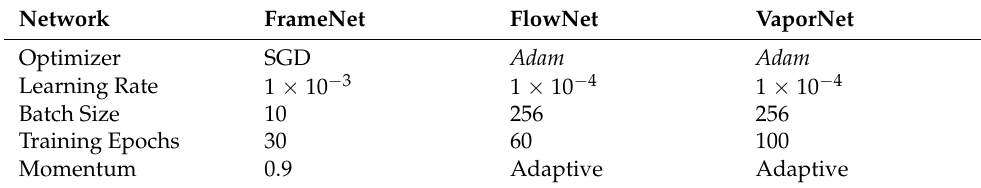
Table 1. The training